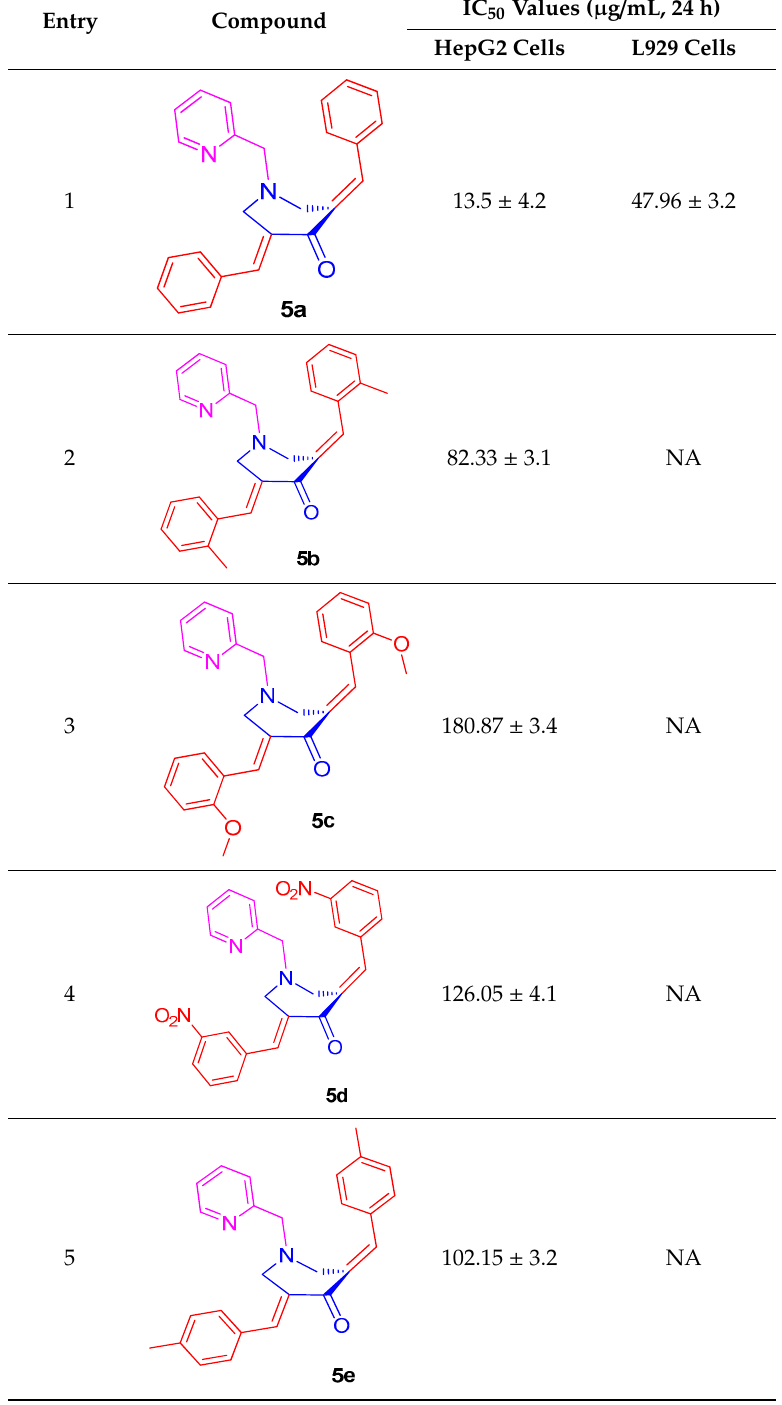
Table 1. Comparison of the IC 50 values of compounds 5(a–h) against HepG2 cancer cells over a 24 h period.